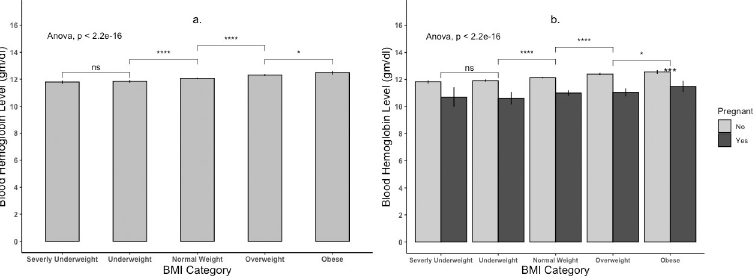
Fig 1. Hemoglobin level of Women (n = 5680) according to BMI Category (Picture a.) and Pregnancy Status (Picture